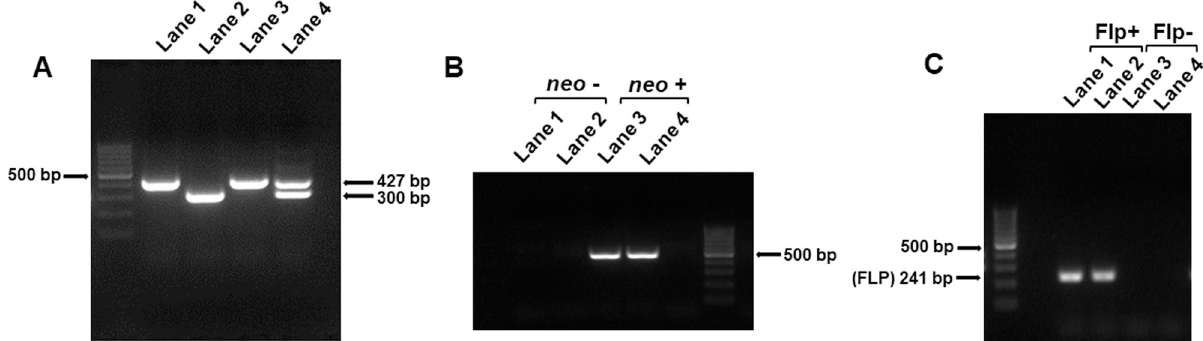
Fig 4. Genomic characterization of Hlcs tm1Jze mice. (A) Pups homozygous for floxed E8 were identified in generation F12 by using PCR. (B) Identification of pups that tested negative (lanes 1 and 2) and positive (lanes 3 and 4) for neo . (C) Identification of pups that tested negative (lanes 3 and 4) and positive (lanes 1 and 2) for Flp. Removal of Flp coincides with loss of neo (see panel B). Flp+, presence of Flp recombinase; Flp-, absence of Flp